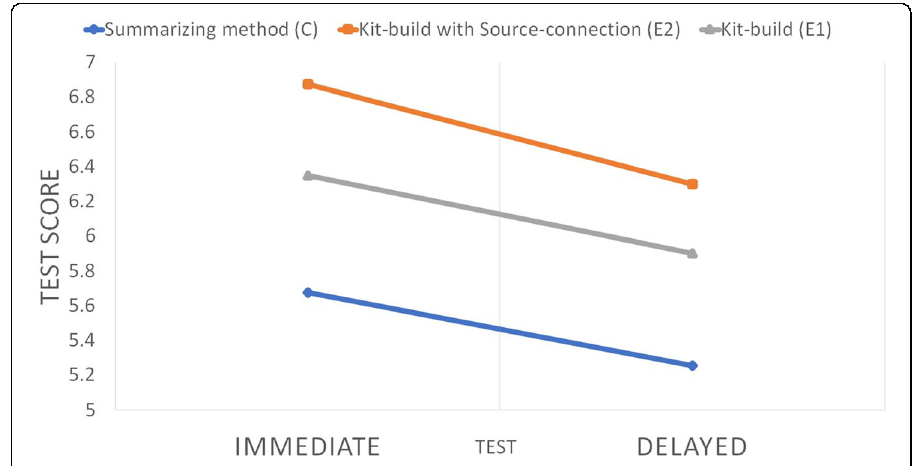
Fig. 8 Graphical test result comparison between groups for Material